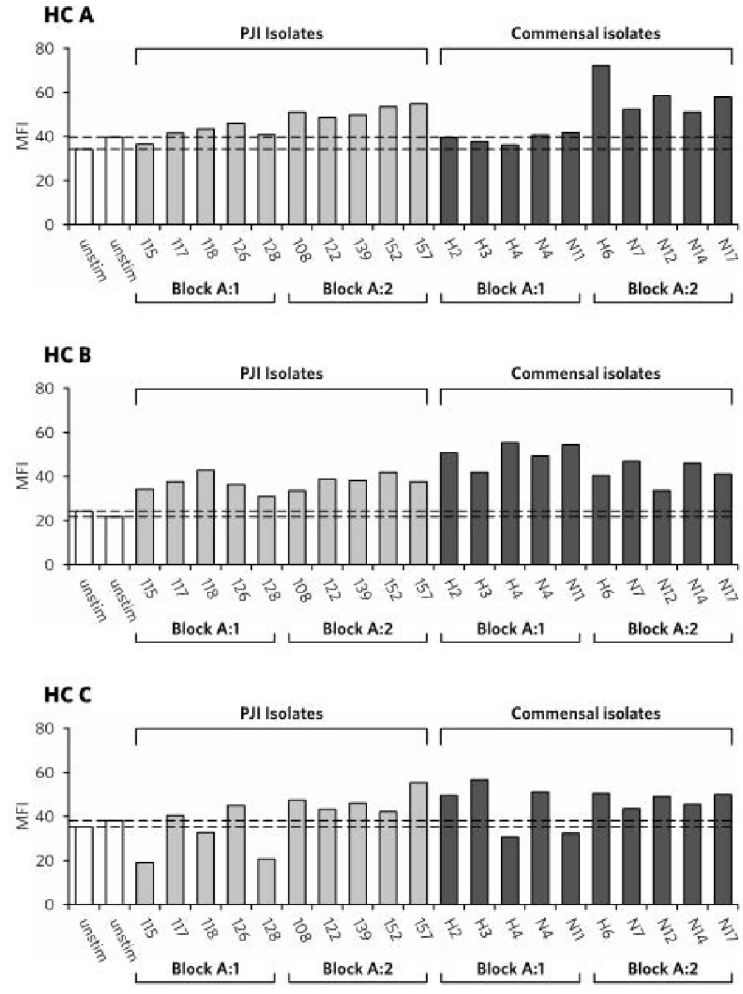
Figure 1. Active caspase-1 in neutrophils after 2h of stimulation, per healthy control (HC A-C) and isolate number. White bars = unstimulated neutrophils, light grey bars = neutrophils stimulated with S. epidermidis isolates from prosthetic joint infections, dark grey bars = neutrophils stimulated with S. epidermidis isolates from normal skin flora. Dotted lines show values for unstimulated controls. MFI = median fluorescence